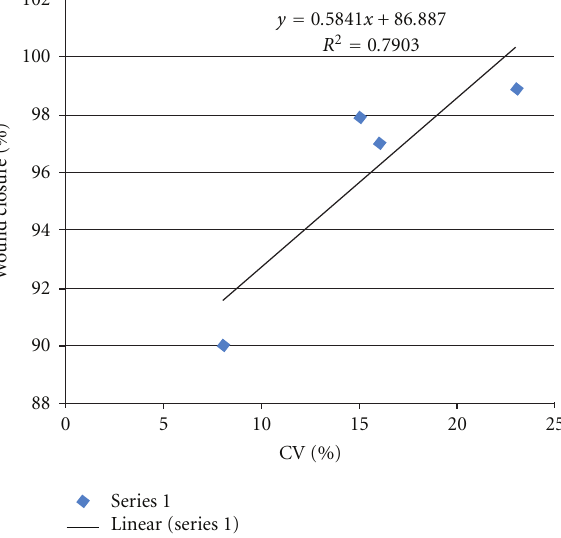
Figure 8: Relationship between capillary vascularity (CV) and wound closure. Data were taken from mean of each group on day